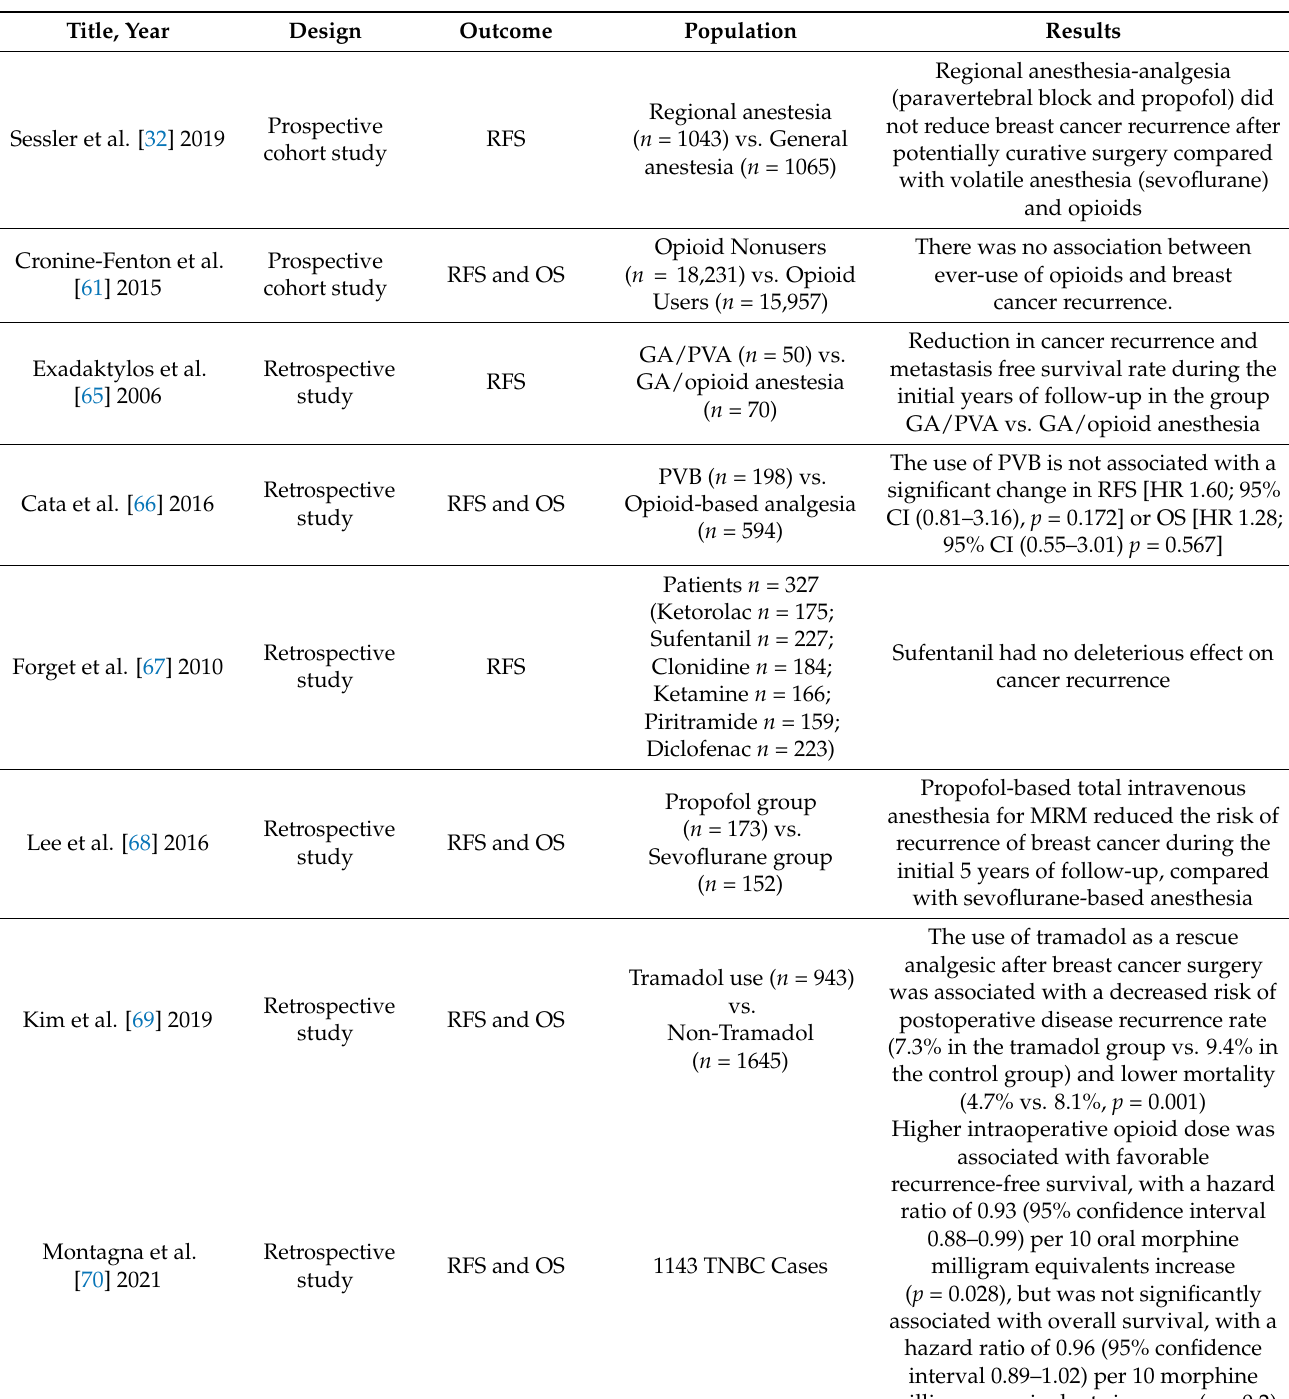
Table 5. Selected retrospective and prospective studies. RFS: recurrence free survival, OS: overall survival, GA: general anesthesia, PVA: paravertebral anesthesia, PVB: paravertebral block, TNBC: Triple-negative breast